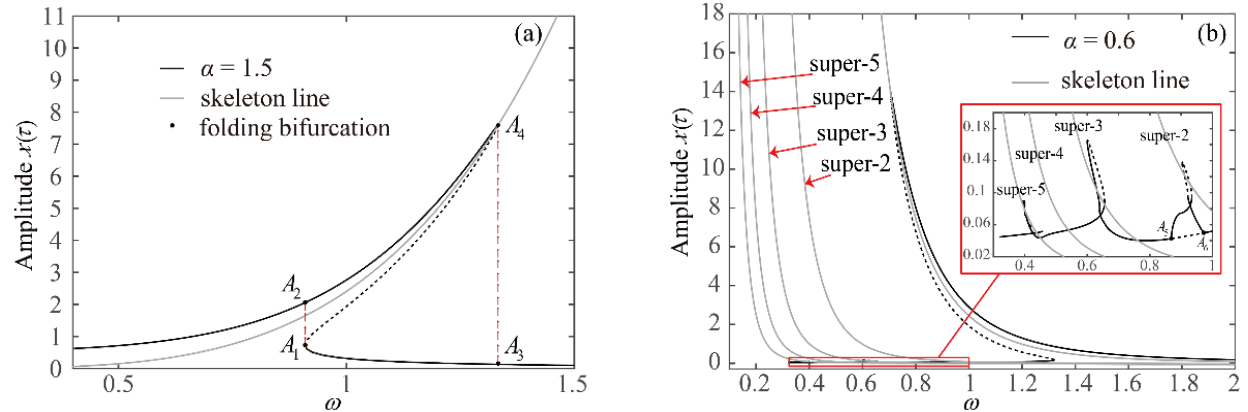
Figure 2. For W = 0, stable (solid) and unstable (dashed) periodic frequency-response peak-to-peak curves of continuous system, ( a ) α = 1.5 and ( b ) α = 0.6.